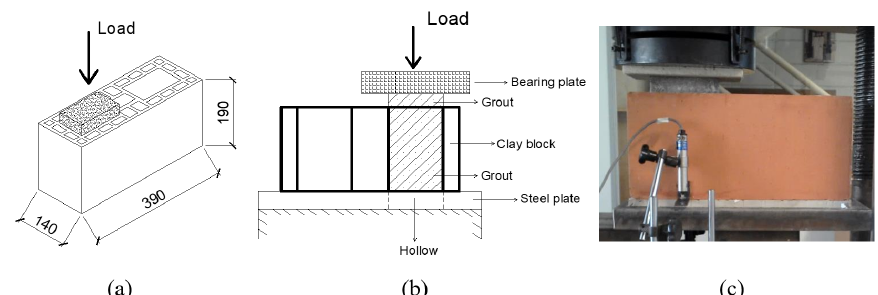
Figure 1. Push-out specimens: (a) Nominal dimensions [in mm], (b) test rig and (c) experimental test (Adapted from Izquierdo et al. [11]).